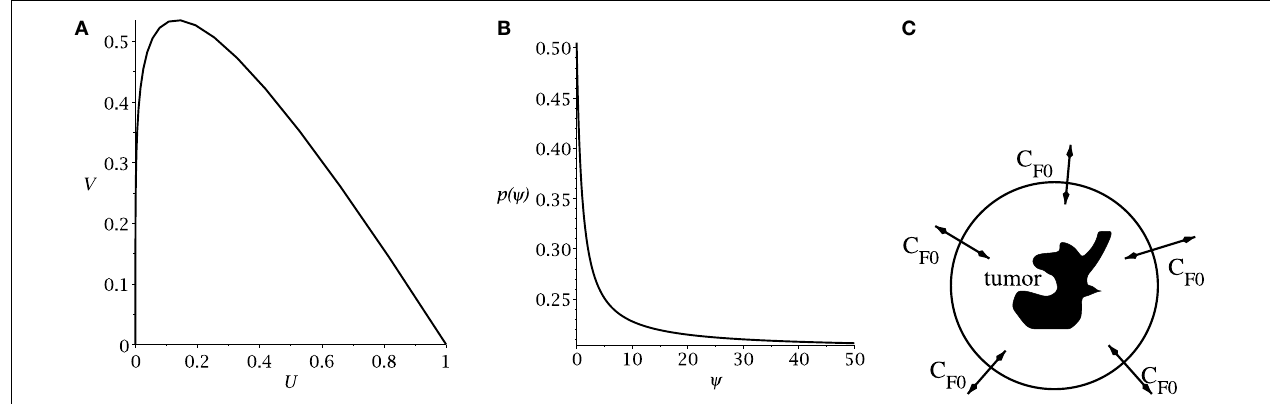
FIGURE 1 | (A) Slow manifold from equation (10) in the ( U , V ) phase plane. (B) rate of symmetric division p ( t ) [equation (7)] as a function of the sensitivity ψ . The values of p max and p min are set to 0.505 and 0.2.The differentiation promoter, C F , is fixed at one. (C) Schematic of the radial diffusion problem for the differentiation promoter C F